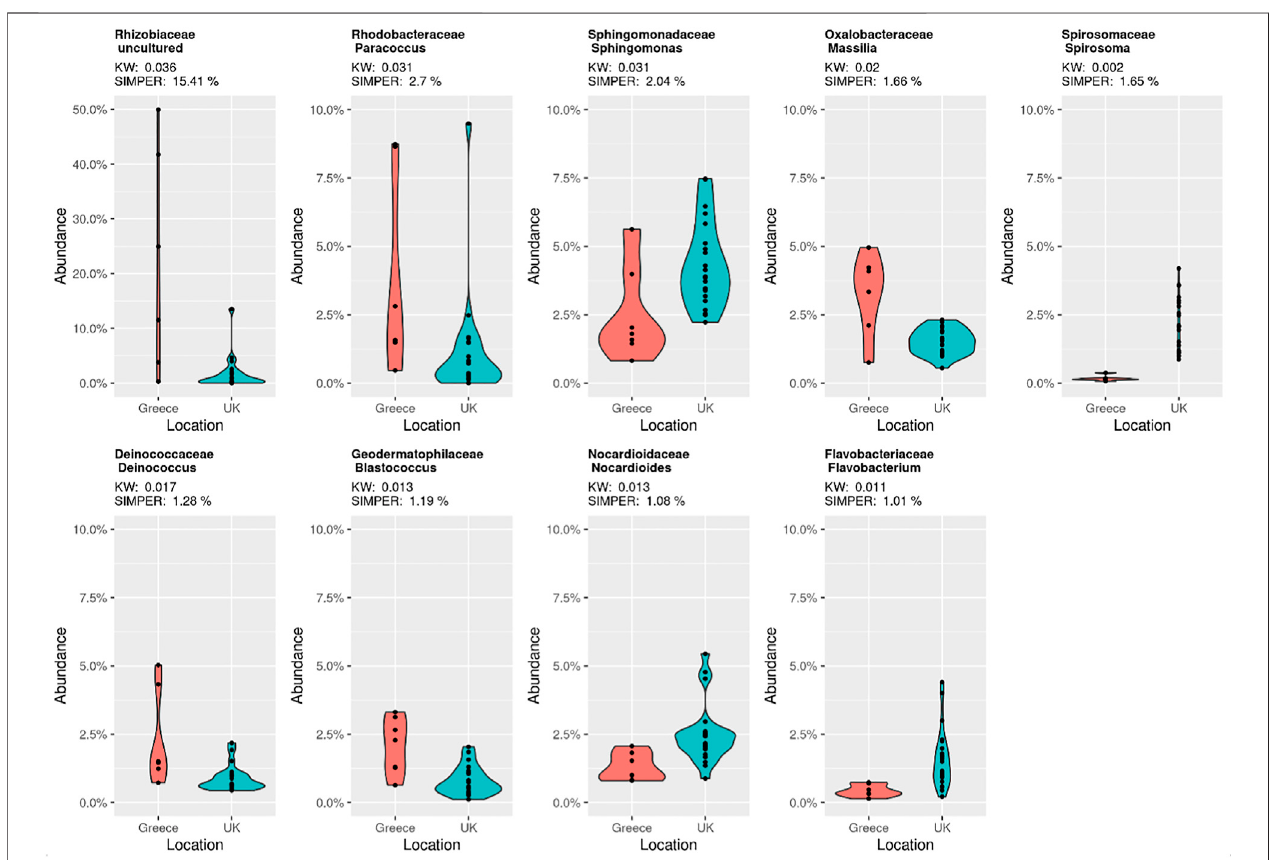
FIGURE2| SIMPERanalysisviolinplotsshowingthestatisticallysigni fi cantFDRadjusted p valuetaxafrom Table1 .ContributingSIMPERandKruskalWallis(KW) values are displayed for each taxon, and by country.